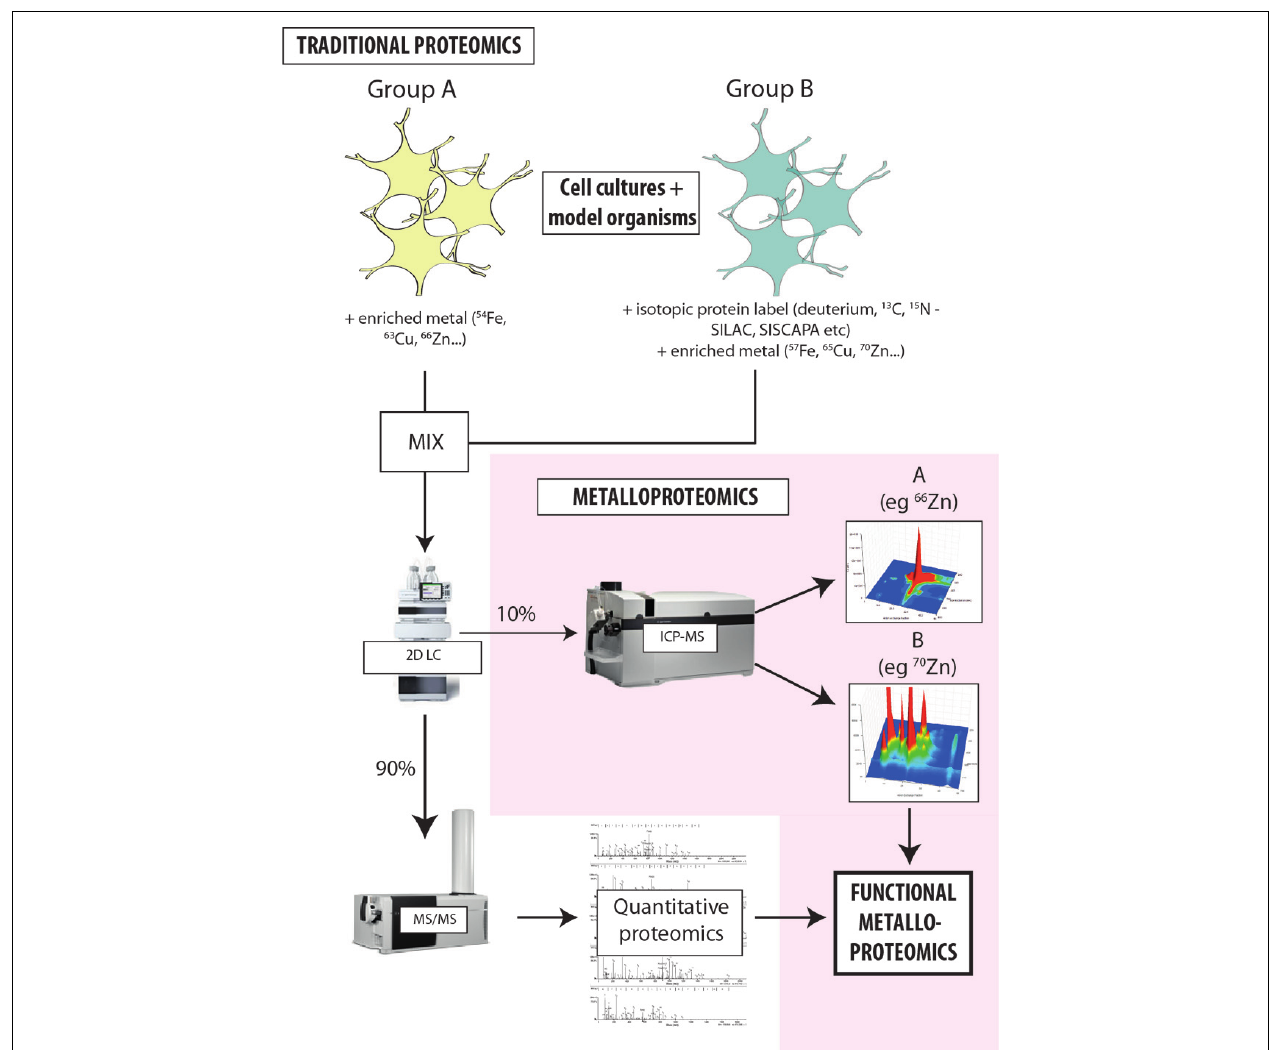
FIGURE 2 | Proposed workflow for integrated metalloproteomics. Hyphenating native separation techniques to ICP-MS is the key to unlocking the secrets of metals and protein function. Rather than relying solely on bulk measures, directly associating metals with specific proteins provides new insight into how metals carry out biochemical processes in the cell. At the current state of our knowledge about the level of metalloproteins in biology the coupling of size exclusion to ICP-MS have the promise of being quantitative thus allowing the comparison of different samples and detail about the global or metalloprotein specific changes that occur. Despite SEC being a low resolution technique it can allow researchers to make educated guesses about the ID of proteins of interests based on their MW. Continued evolution of hyphenated LC-ICP-MS will only increase the arsenal of tools